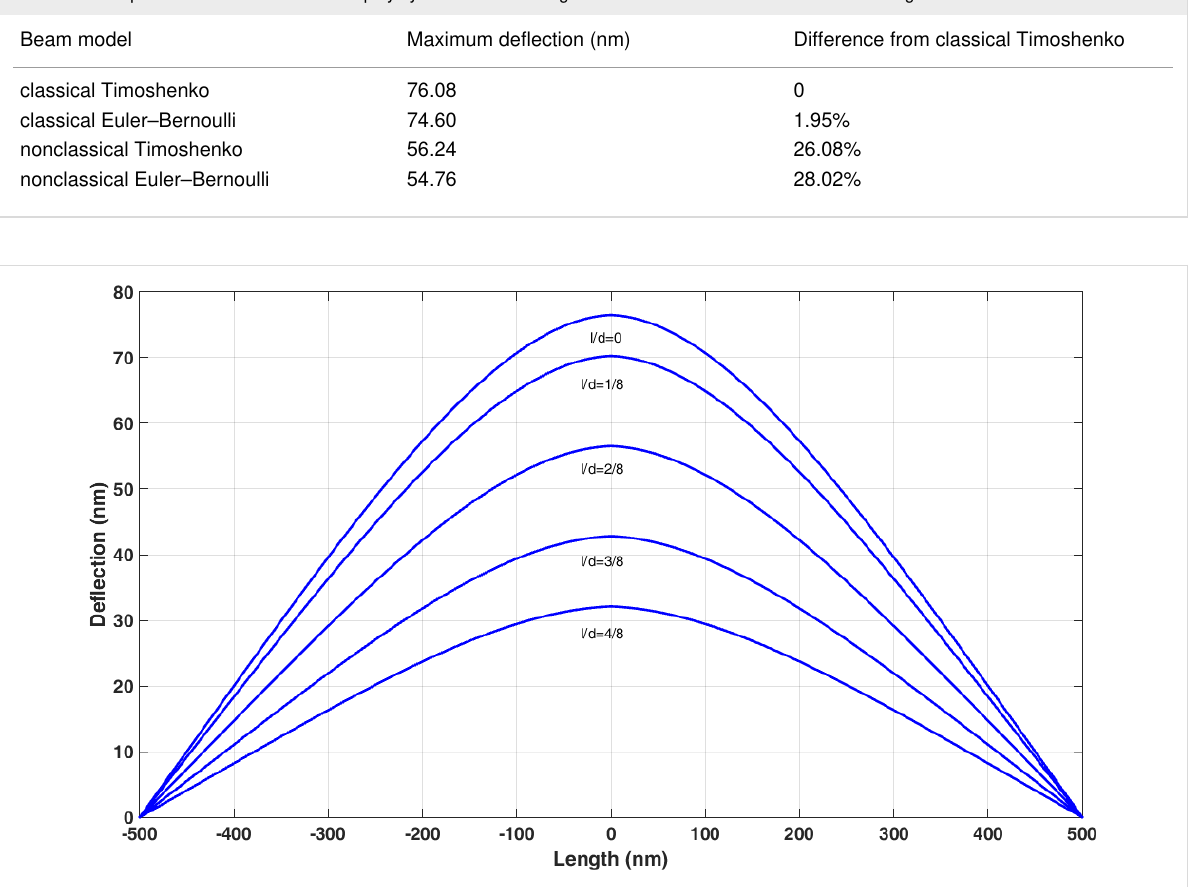
Table 11: Comparison of the deflections of a polystyrene nanorod using classical and nonclassical models assuming l / d = 0.25.